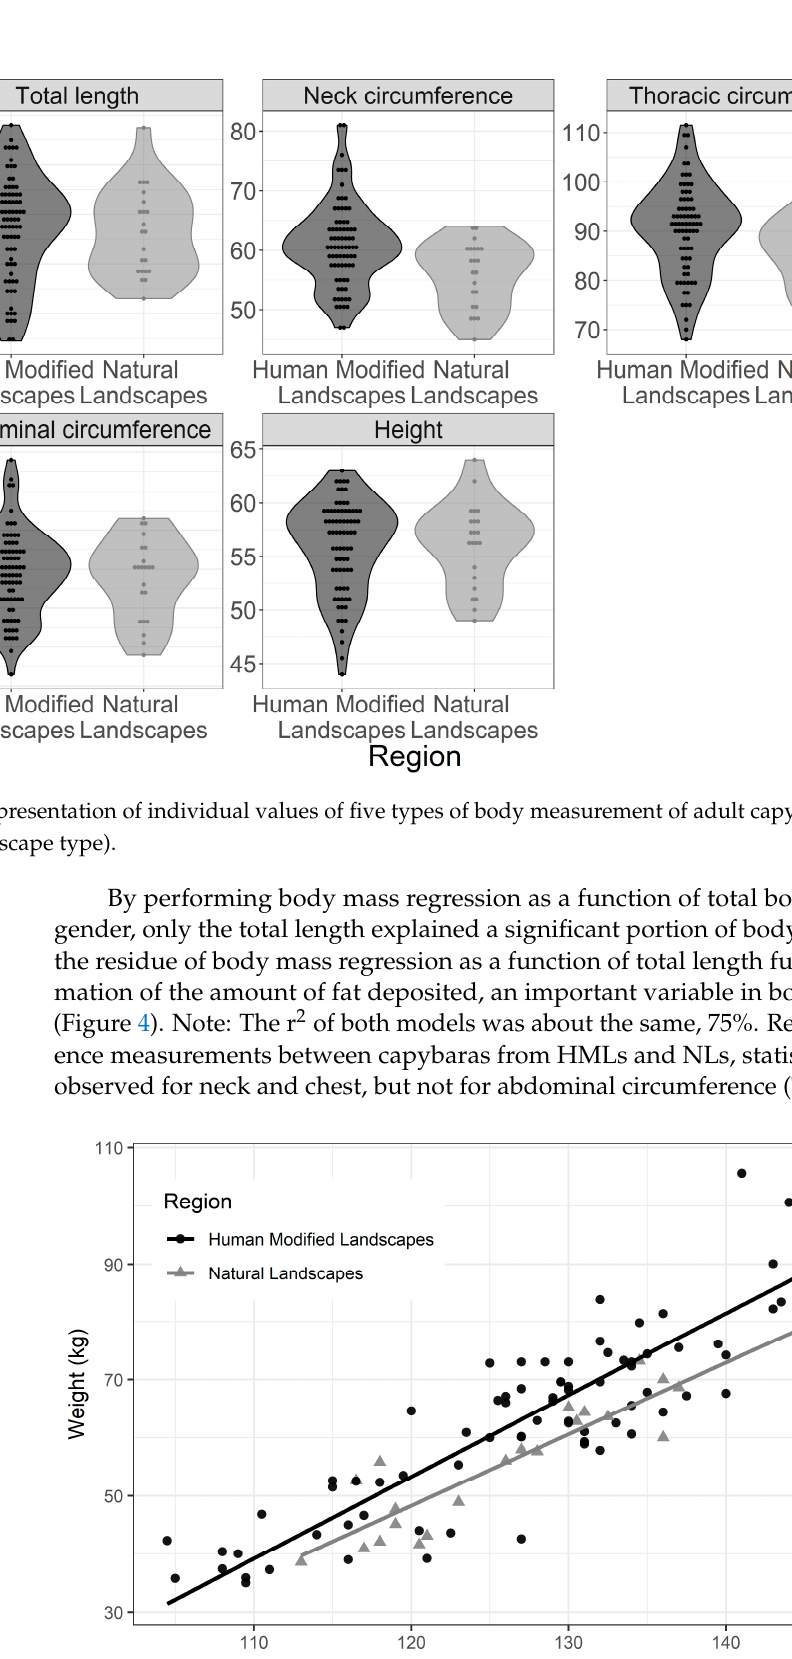
Table 4. Body Condition Index average values of capybaras from human-modified landscapes (HMLs) and natural landscapes (NLs). Formula